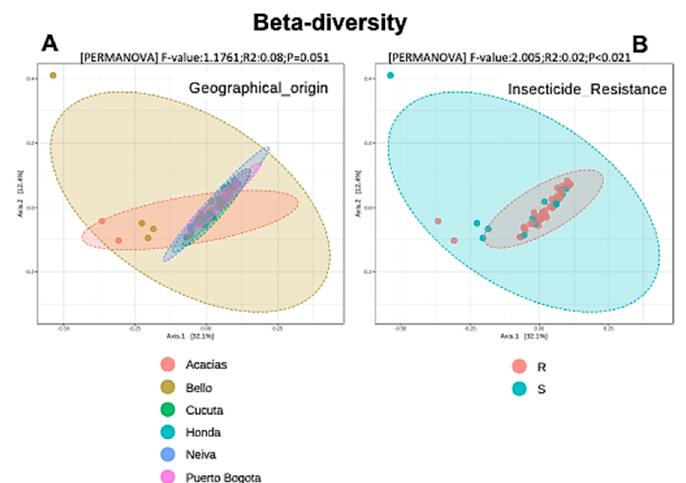
Figure 5. Principal coordinate analysis (PCoA) based on Bray-Curtis distances showing the diversity among six Colombian Aedes aegypti populations. ( A ) Beta diversity between geographical origins. ( B ) Beta diversity between insecticide-resistant and -susceptible mosquitoes. The observed diversity was only statistically significant among mosquitoes with different phenotypic profiles to lambda-cyhalothrin ( p < 0.021).